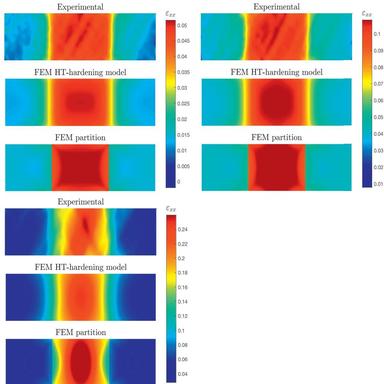
Comparison between numerical strain fields xx and DIC data at three different horizontal displacement loads Ux along the test's time history.